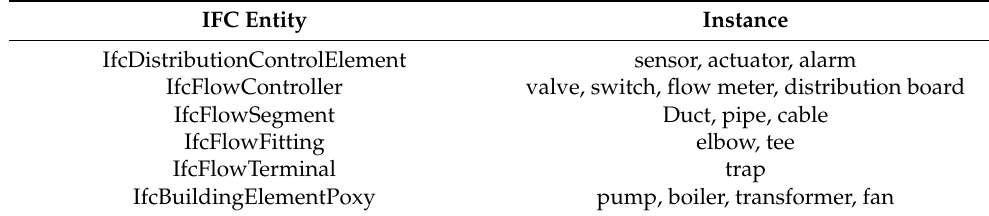
Table 2. MEP system entities and